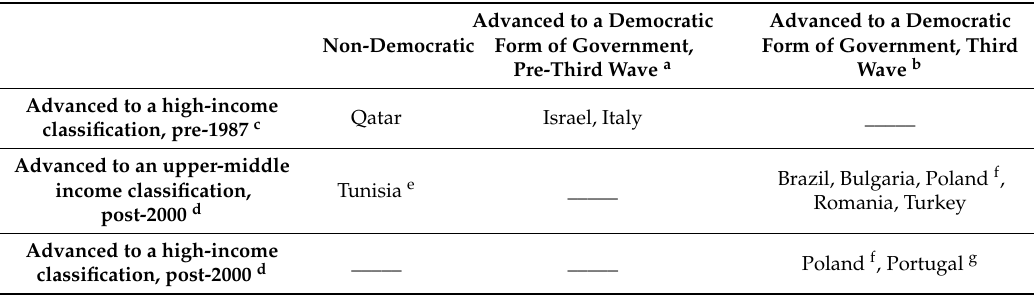
Table 4. Advancements to a democratic form of government and higher income